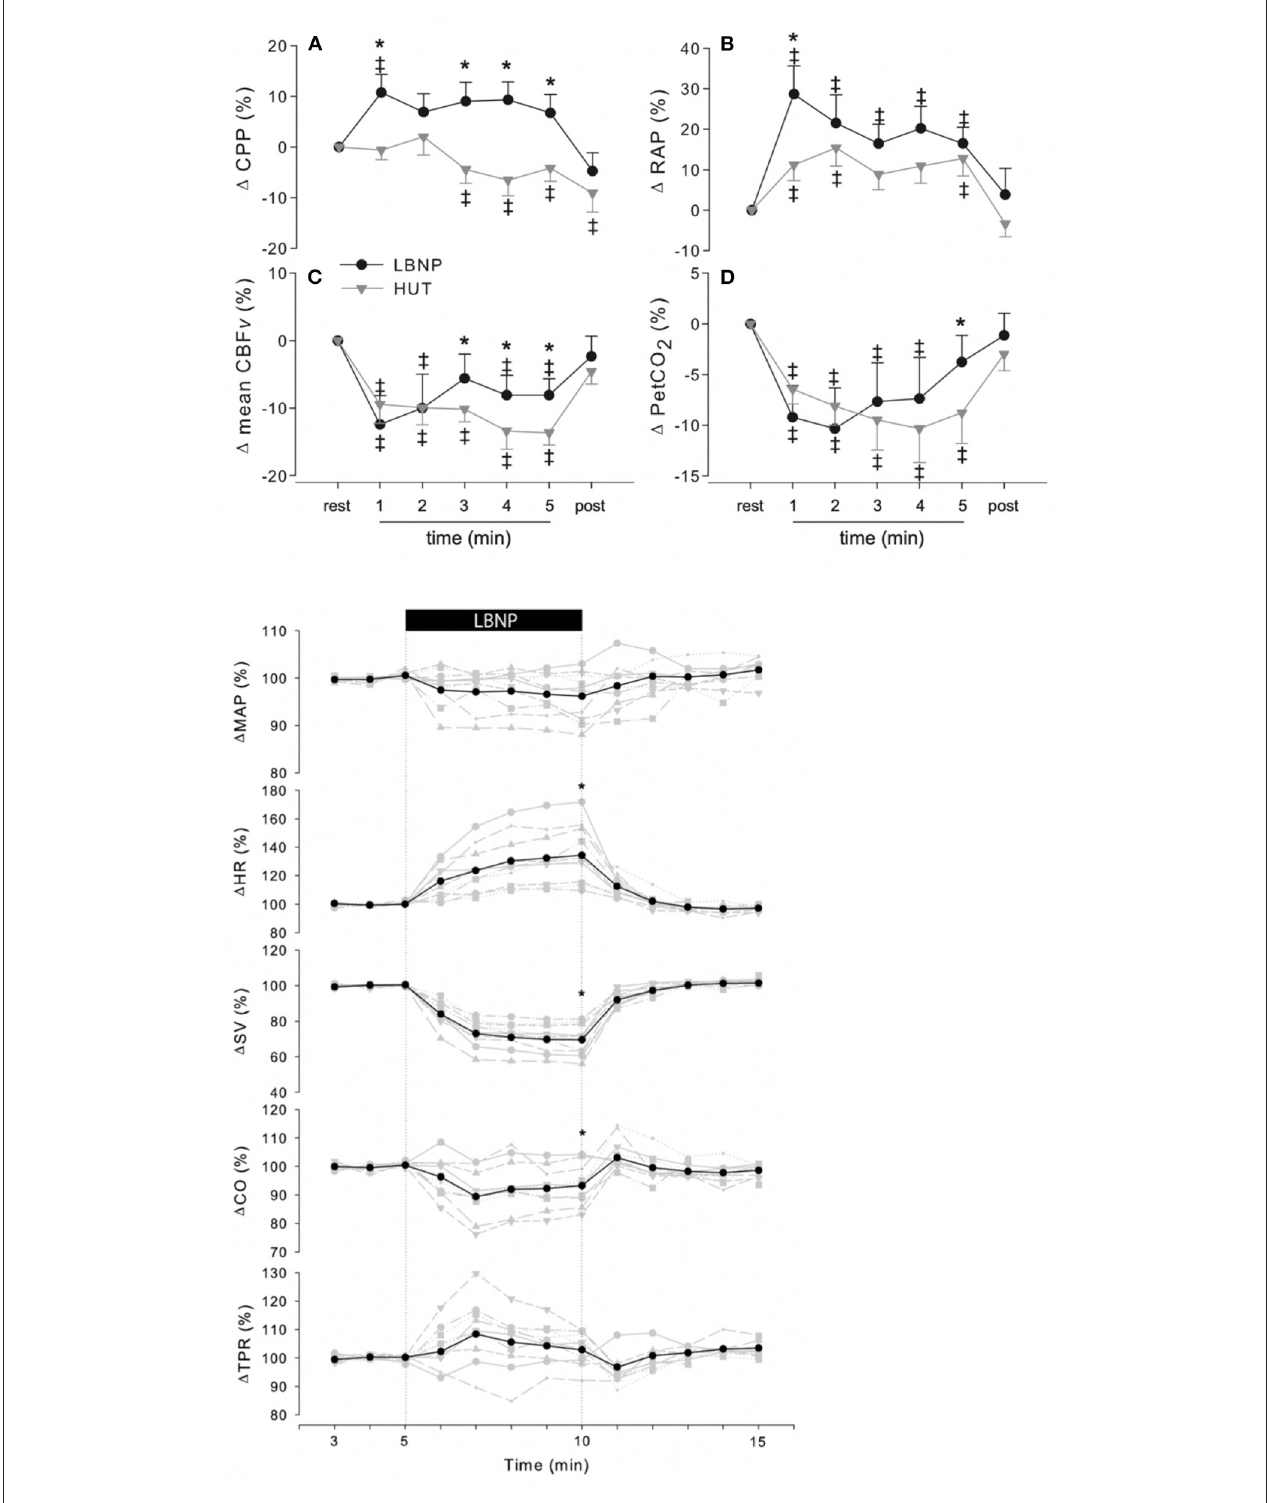
FIGURE 1 | (A–D) Change in cerebrovascular response to 5min LBNP − 50 mmHg — (black circles) or 70 ◦ passive HUT (gray triangles). CPP, cerebral perfusion pressure; RAP, resistance area product; CBFv, cerebral blood flow velocity; PetCO 2 , end-tidal CO 2 ; LBNP, lower body “negative” or sub-atmospheric